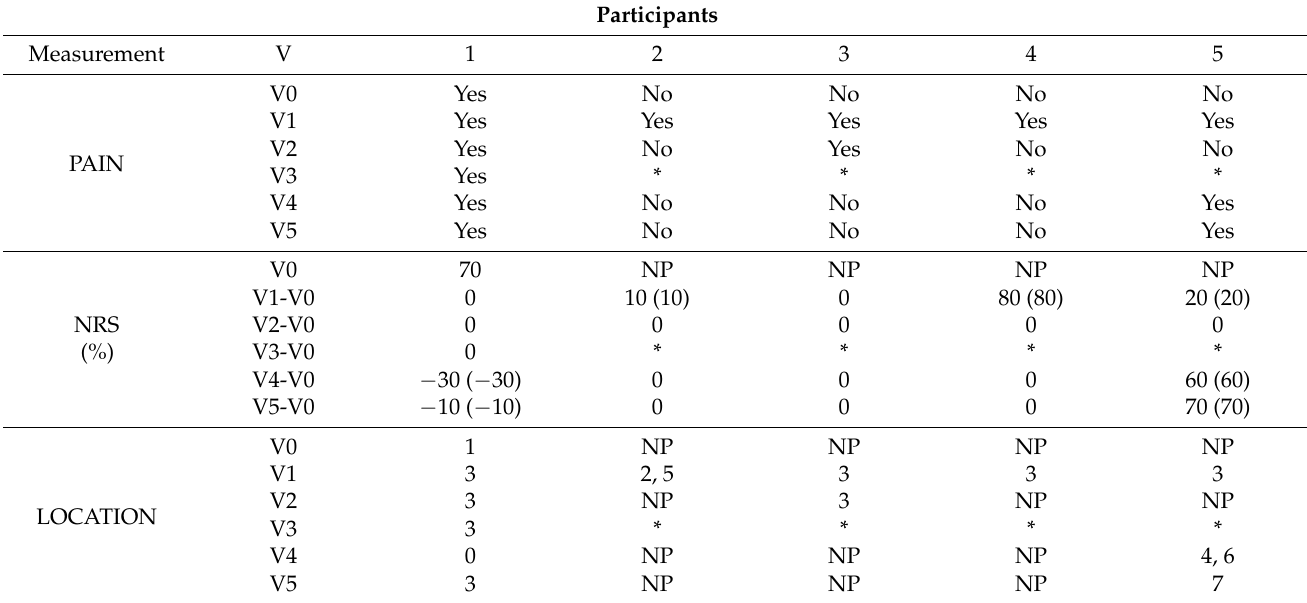
Table 2. Pain characterization of the sample.